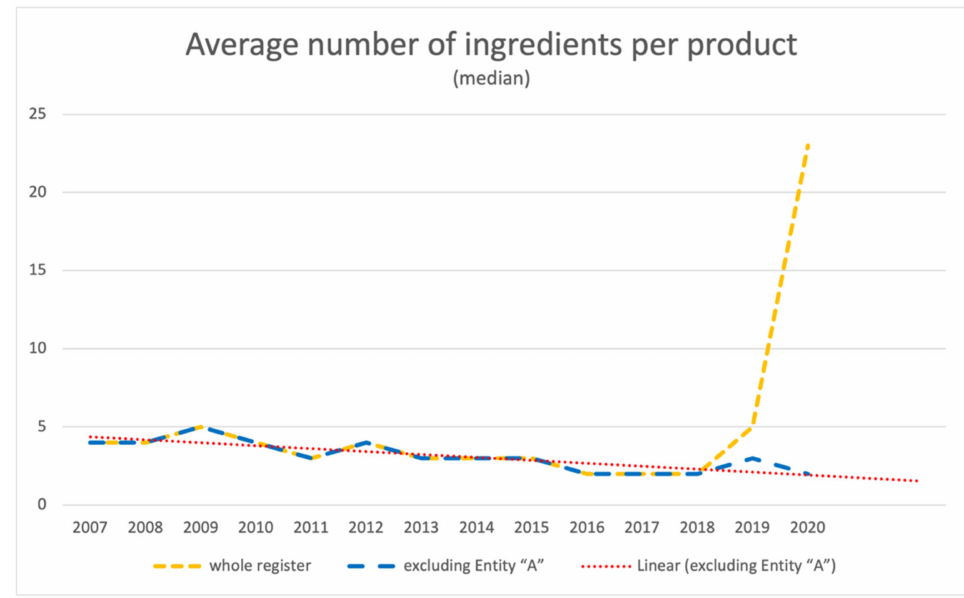
Figure 5. Average number of ingredients per product.